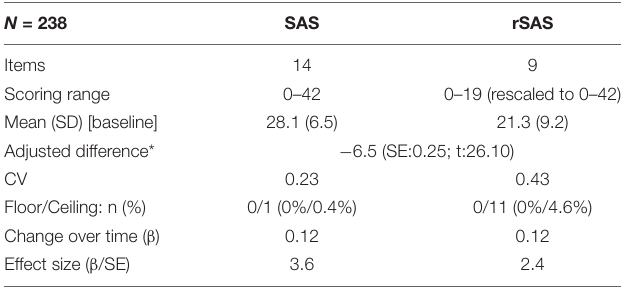
TABLE 6 | Floor and Ceiling Effects and Responsiveness of the original SAS and